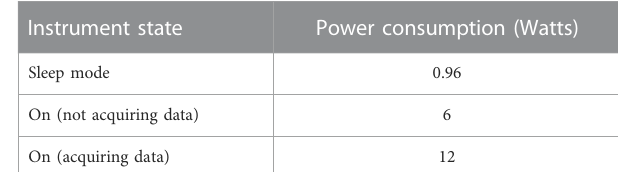
TABLE 1 Instrument power consumption in different